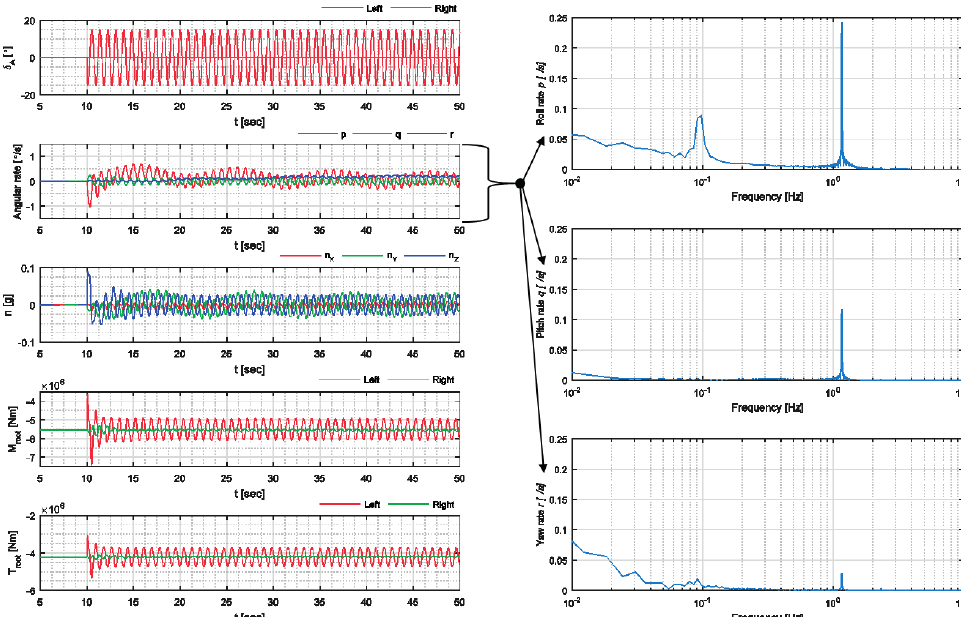
Fig. 12. Ailerons deflection δ A , angular rate, load factor n , wing root bending moment M root and wing root torsion T root and the roll, pitch and yaw rates at the aileron excitation frequency f = 1.1634 Hz